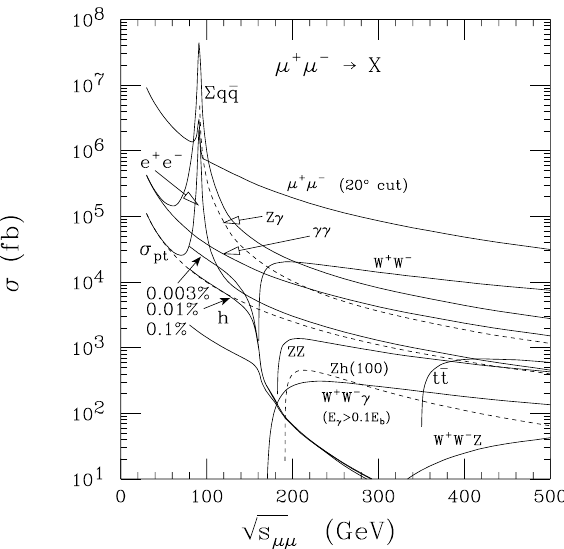
FIG. 4. Cross sections for SM processes vs the COM energy at the FMC. s pt (cid:6) s (cid:3) m 1 m 2 ! g (cid:1) ! e 1 e 2 (cid:4)